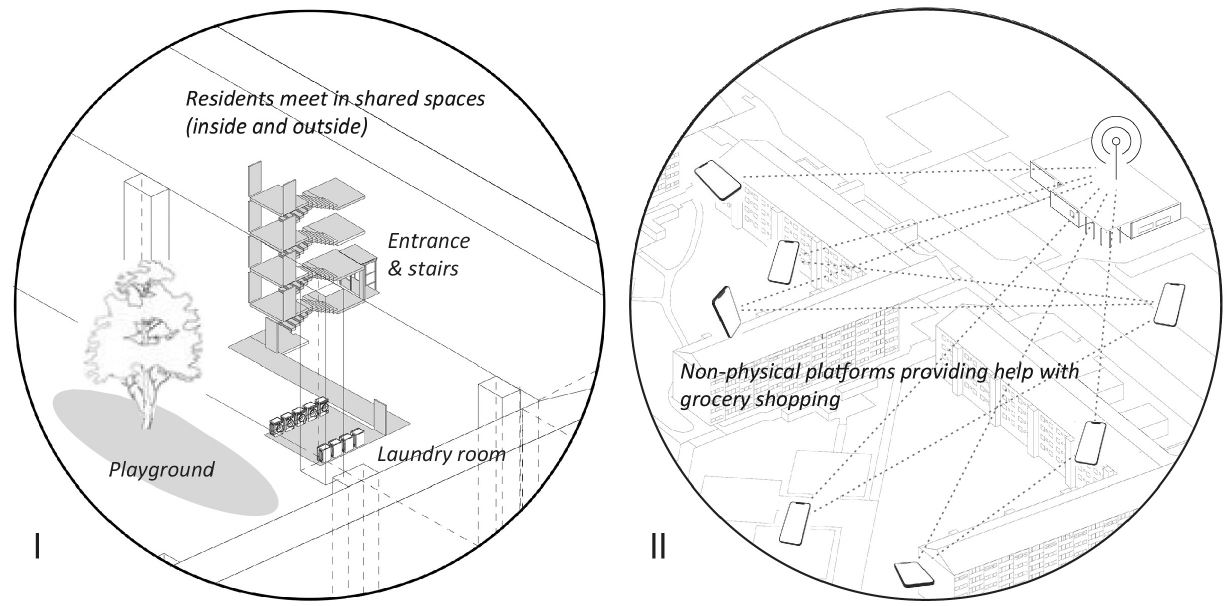
Figure 2. Informal and shared spaces (I) and non‐physical platforms (II) in